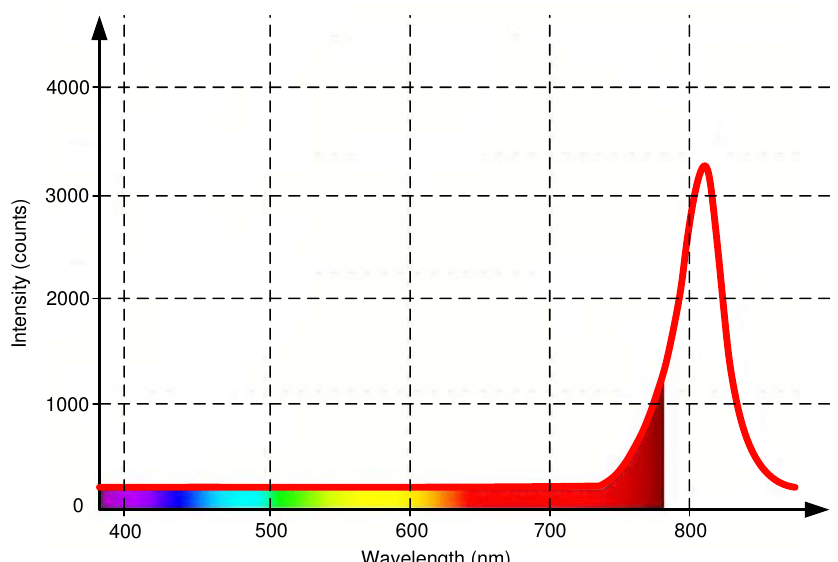
Distribution of the colors along the visible spectrum (from 390 to 780 nm approximately) along with the light emission of the selected infrared LEDs (red solid